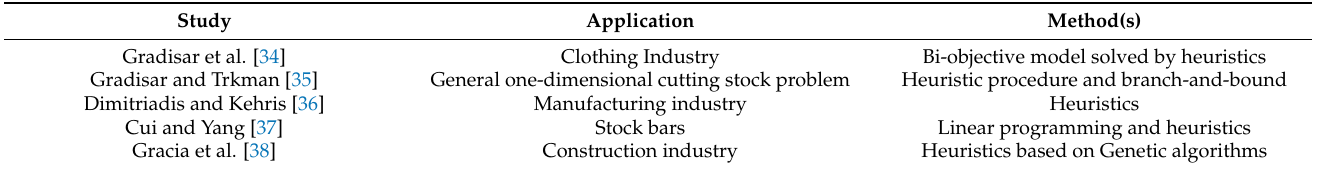
Table 1. Summary of cutting stock